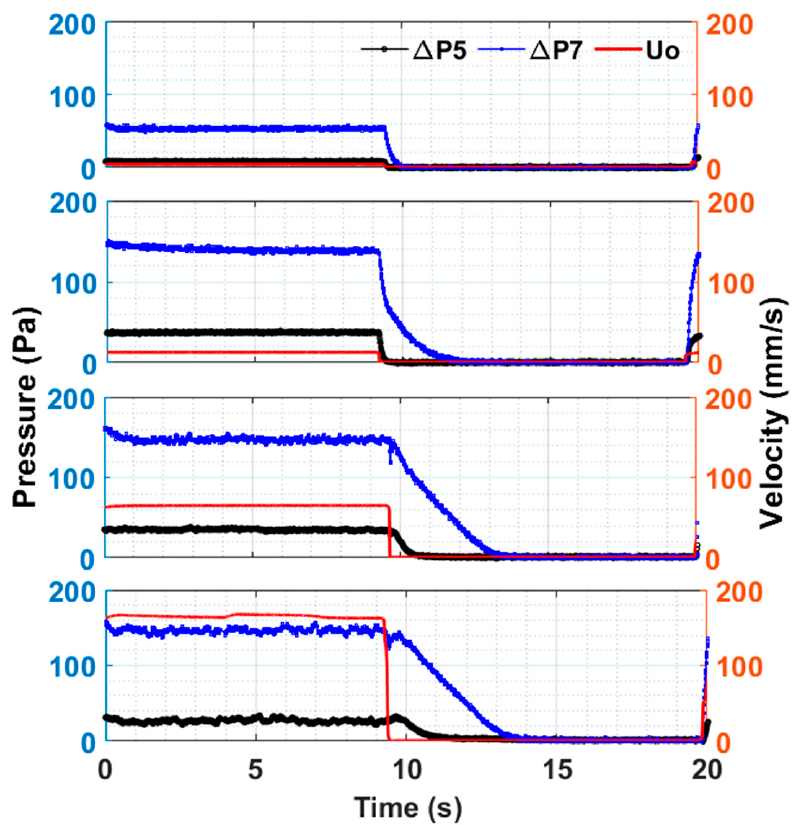
Figure 9. Global ( ∆ P 7 and local (lower region, ∆ P 5 ) bed dynamics in pulsed fluidized bed for 4 mm / s, Figure 9. Global ( Δ𝑃 (cid:2875) ) and local (lower region, Δ𝑃 (cid:2873) ) bed dynamics in pulsed fluidized bed for 4 mm/s, 12 mm / s, 65 mm / s, 165 mm / s during 12 mm/s, 65 mm/s, 165 mm/s during fluidization